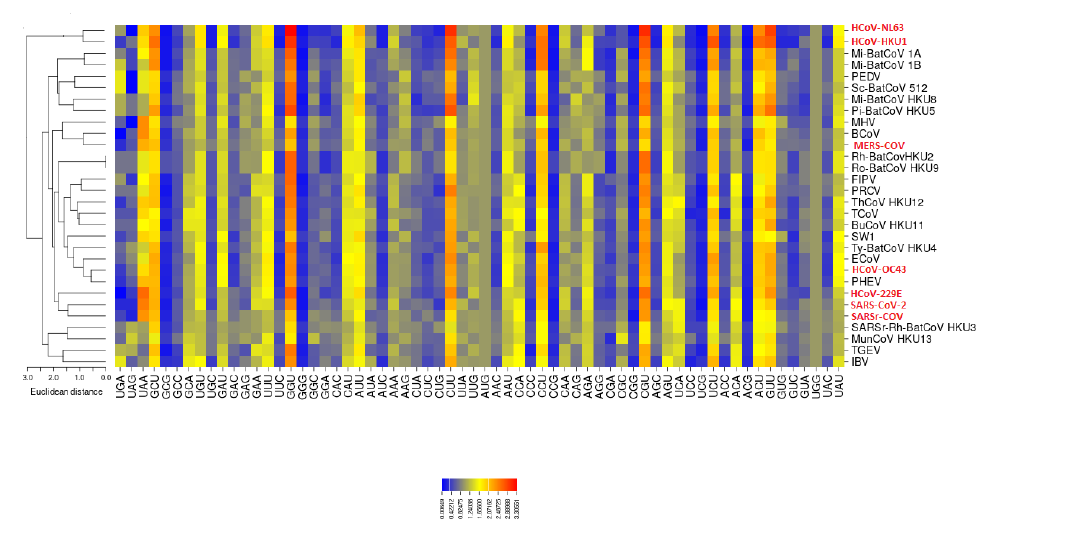
Figure 1. Clustering of the relative synonymous codon usage (RSCU) vectors associated with the 30 coronaviruses. Human coronaviruses are shown in red. The newly identified SARS-CoV-2 coronavirus is closer to HCoV-229E and SARSr-CoV in terms of codon usage, as measured by their RSCU vectors. Heatmap was drawn with the CIMminer software [20], which uses Euclidean distances and the average linkage